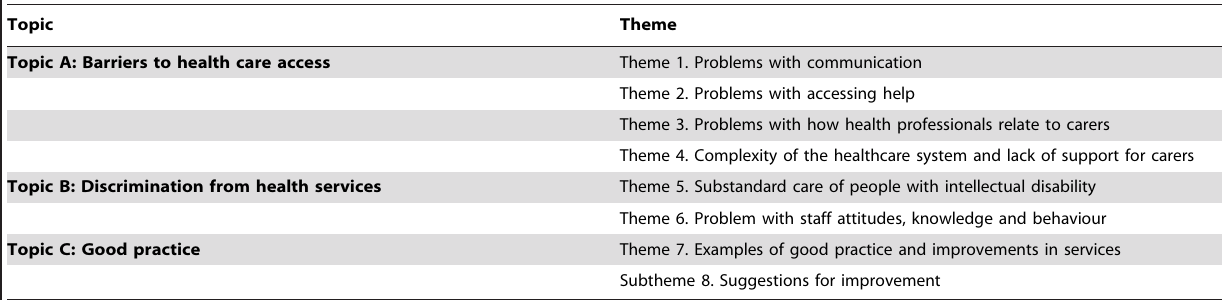
Table 3. Summary of themes and